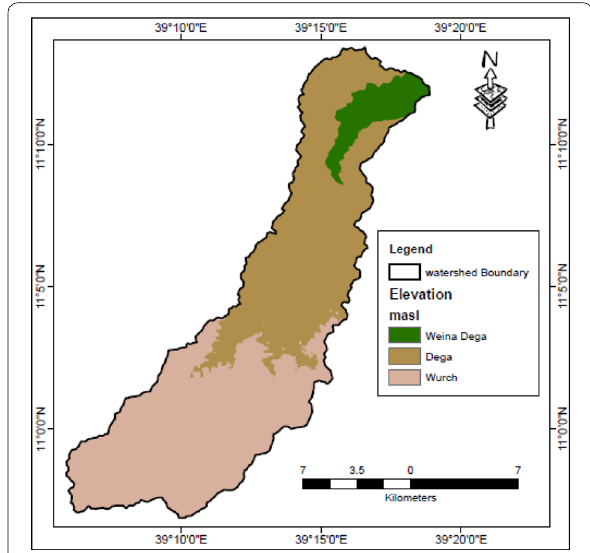
Fig. 3 Agro ecological belts of the Gedalas watershed